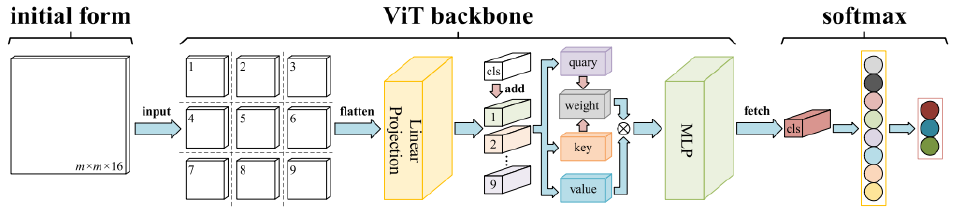
Figure 12. Overview of the ViT-PolSAR framework [141] for supervised polarimetric SAR image classification. Here, the pixel values of the SAR image patches are considered as tokens and then the self-attention mechanism is utilized to encode longe-range dependencies followed by MLP. Figure is from [141]. Best viewed zoomed in.